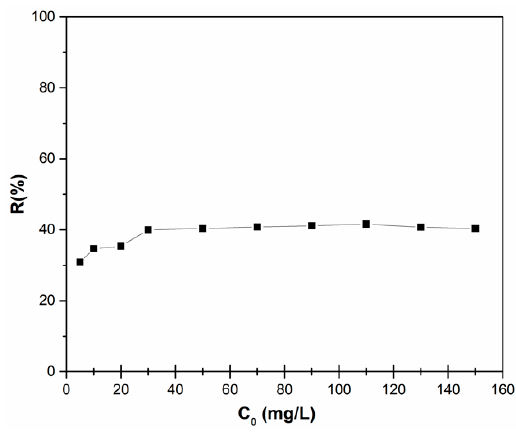
Figure 6. Removal efficiency of zinc ions on HAp depending on the initial zinc concentration. Table 1. The percentage of zinc ions removal and adsorption capacity of HAp upon varying the zinc concentrations.